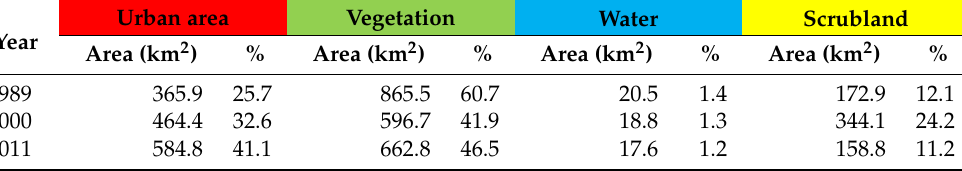
Table 3. Spatial distribution of LULC classified data.